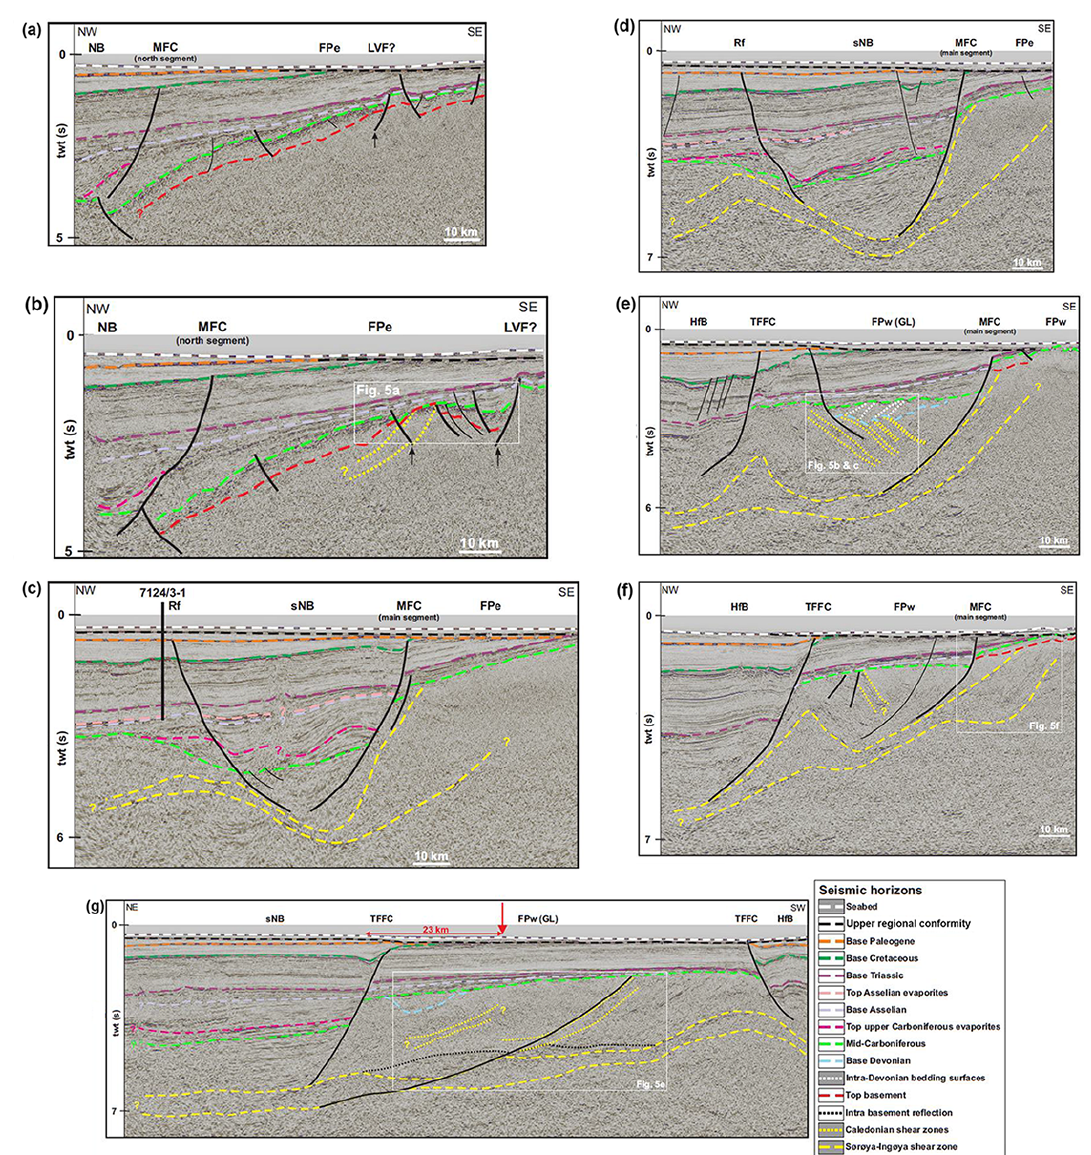
Figure 5. Examples of interpreted seismic profiles from the BSS-01 survey (2-D), the locations of which are displayed in Fig. 2. Brittle faults are shown in black and depth is in seconds (s) TWT. See Fig. 1 for abbreviations; (a) interpreted seismic section that shows a system of Carboniferous horst and graben structures on the eastern Finnmark Platform; (b) seismic profile showing increased normal displacement across the NW-dipping LVF compared with panel (a) and thickening of the Carboniferous sedimentary succession within the graben bounded by the LVF. Note the insignificant amount of the displacement accommodated by the northern segment of the MFC in panels (a) and (b) . Black arrows mark brittle faults that bound a triangular-shaped, negative aeromagnetic anomaly (see dashed white line in Fig. 4); (c) seismic profile showing a highly thickened Carboniferous succession and potential Devonian–lower Carboniferous sedimentary rocks in the southwesternmost Nordkapp basin. Note the large offset accommodated by the main segment of the MFC and the peculiar “U” shape of the southwesternmost Nordkapp basin. Also displayed is a lateral projection of exploration well 7124/3-1; (d) interpreted seismic section that shows the listric geometries of the main segment of the MFC and of the Rolvsøya fault; (e) seismic section showing potential Devonian sedimentary rocks deposited in a NE–SW-trending graben above a set of minor, SE-dipping shear zones on the western Finnmark Platform; (f) seismic section showing the listric geometries of the TFFC and MFC, which both seem to merge into the SISZ; (g) NE–SW-trending seismic cross section across the western Finnmark Platform and the southwesternmost Nordkapp basin showing the gentle dip of the SISZ to the northeast and a gradual thinning of the upper Carboniferous sedimentary succession towards the southwest. A major NNE–SSW-trending, SE-dipping brittle fault seems to offset the SISZ and an intra-basement reflection on the western Finnmark Platform before being truncated by the mid-Carboniferous reflection. The vertical red arrow shows the location of the imaginary prolongation of the TKFZ on the western Finnmark Platform as a comparison with the actual location of the WNW–ESE-trending fault segment of the TFFC, which are separated by a distance of ca.